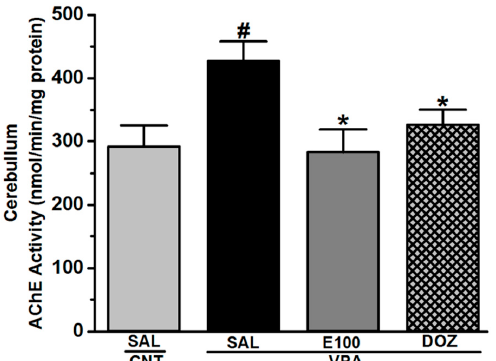
Figure 5. Effects of E100 on acetylcholine esterase activity in cerebellum tissues of valproic acid (VPA)-exposed mice. Inhibitory effects of E100 (10 mg/kg, i.p.) on acetylcholine esterase enzyme in the cerebellum of VPA mice. Quantitative analysis revealed a significant increase ( # p < 0.05) in the acetylcholine esterase enzyme activity in cerebellum of VPA mice compared to the CNT mice.